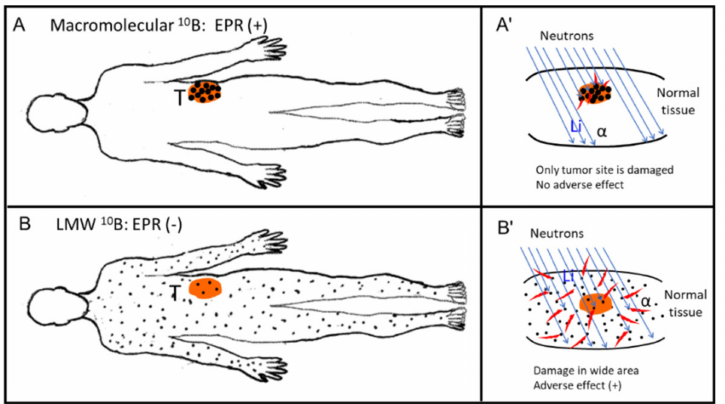
Figure 7. Body distribution of boron-containing drugs. ( A ) Body distribution of a macromolecular 10 B compound (e.g., SGB-complex). ( B ) Distribution of an LMW 10 B compound. In ( A ), boron- containing micelles such as the SGB-complex accumulates predominantly in tumor tissue (T), with the accumulation being about 10 times greater than that of a LMW compound or all other normal tissues in ( B ). ( A’ , B’ ) at right represent enlarged views of the neutron irradiation sites. In ( A’ ), only tumor tissue is damaged: boron micelles (back dots) are evident only in the tumor (T). In ( B’ ), neighboring normal tissue to tumor the boron compound are distributed in most normal tissues such as skin, which will be then be damaged. Red specks around black dots indicate the area of emission of α -particles. ( B’ ) shows that a wide area of tissue is damaged in ( B’ ) (adverse effect). As Figure 7B illustrates, BPA exists in both normal and cancer tissues. Therefore, BPA may affect normal tissue such as the skin as well as cancer-neighboring normal tissues other than tumor tissue. For instance, when treating an oral cancer with BNCT, vocal cords